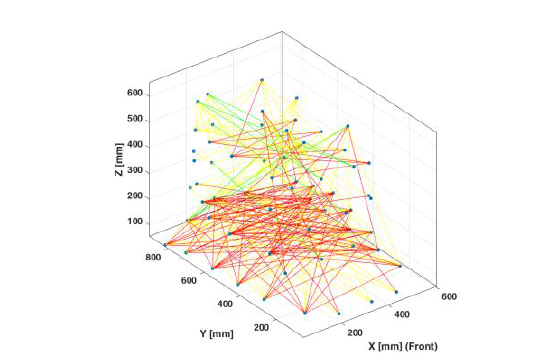
Figure 13. The Euclidean straight paths used in 3D UTI processing. Ray colour codes refer to apparent velocities: red